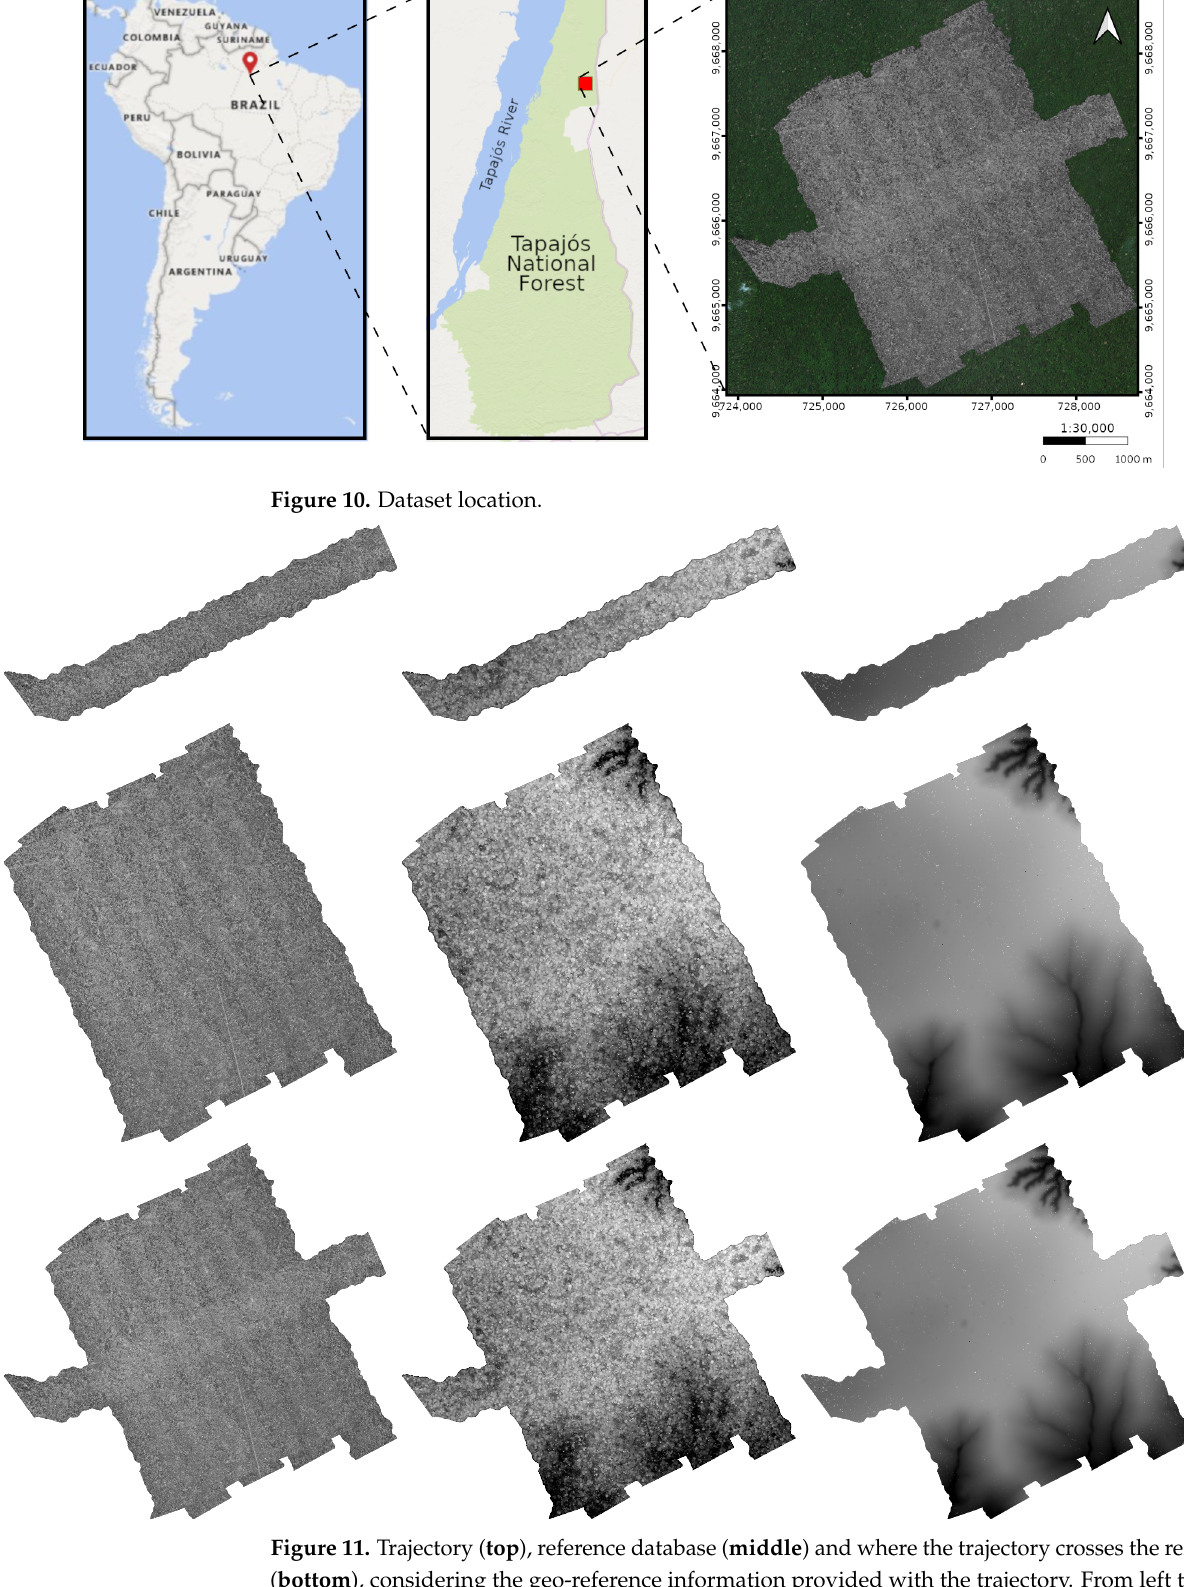
Figure 11. Trajectory ( top ), reference database ( middle ) and where the trajectory crosses the reference ( bottom ), considering the geo-reference information provided with the trajectory. From left to right: intensity, surface and terrain images. The template matching algorithm correctly estimates a position when the estimated position matches same the position given by its geo-reference information over the reference database. Deviations from that position are